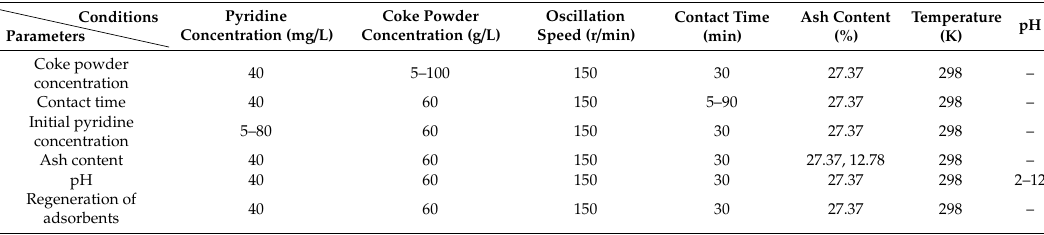
Table 1. The parameters and conditions of batch adsorption tests in this